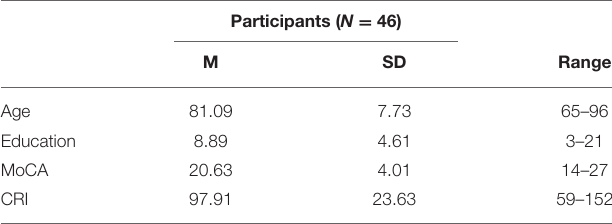
TABLE 1 | Descriptive data of participants: Age, years; Education, years of formal education; MoCA, raw scores at the MoCA test (Nasreddine et al., 2005); CRI, Cognitive Reserve Index (from the Cognitive Reserve Index questionnaire; Nucci et al., 2012); M, mean; SD, standard